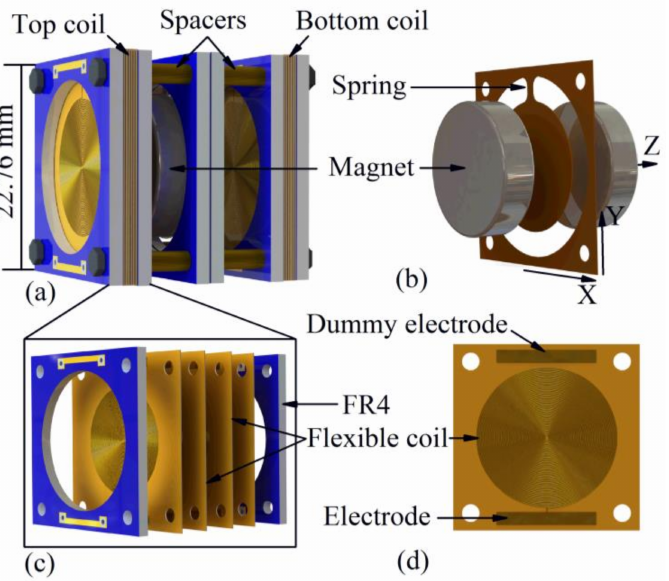
Figure 1. Schematic illustration of the: ( a ) EVEH device; ( b ) pendulum-like suspended magnet by polymer spring; ( c ) stacked polymer coils; and ( d ) a layer of polymer